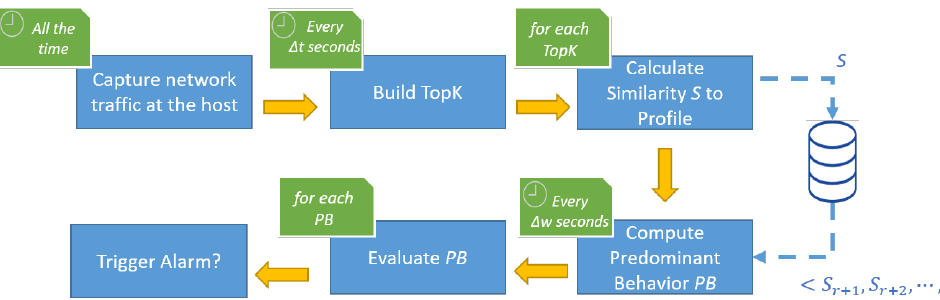
Figure 6. Block diagram of the proposed methodology for detecting an unexpected behavior.